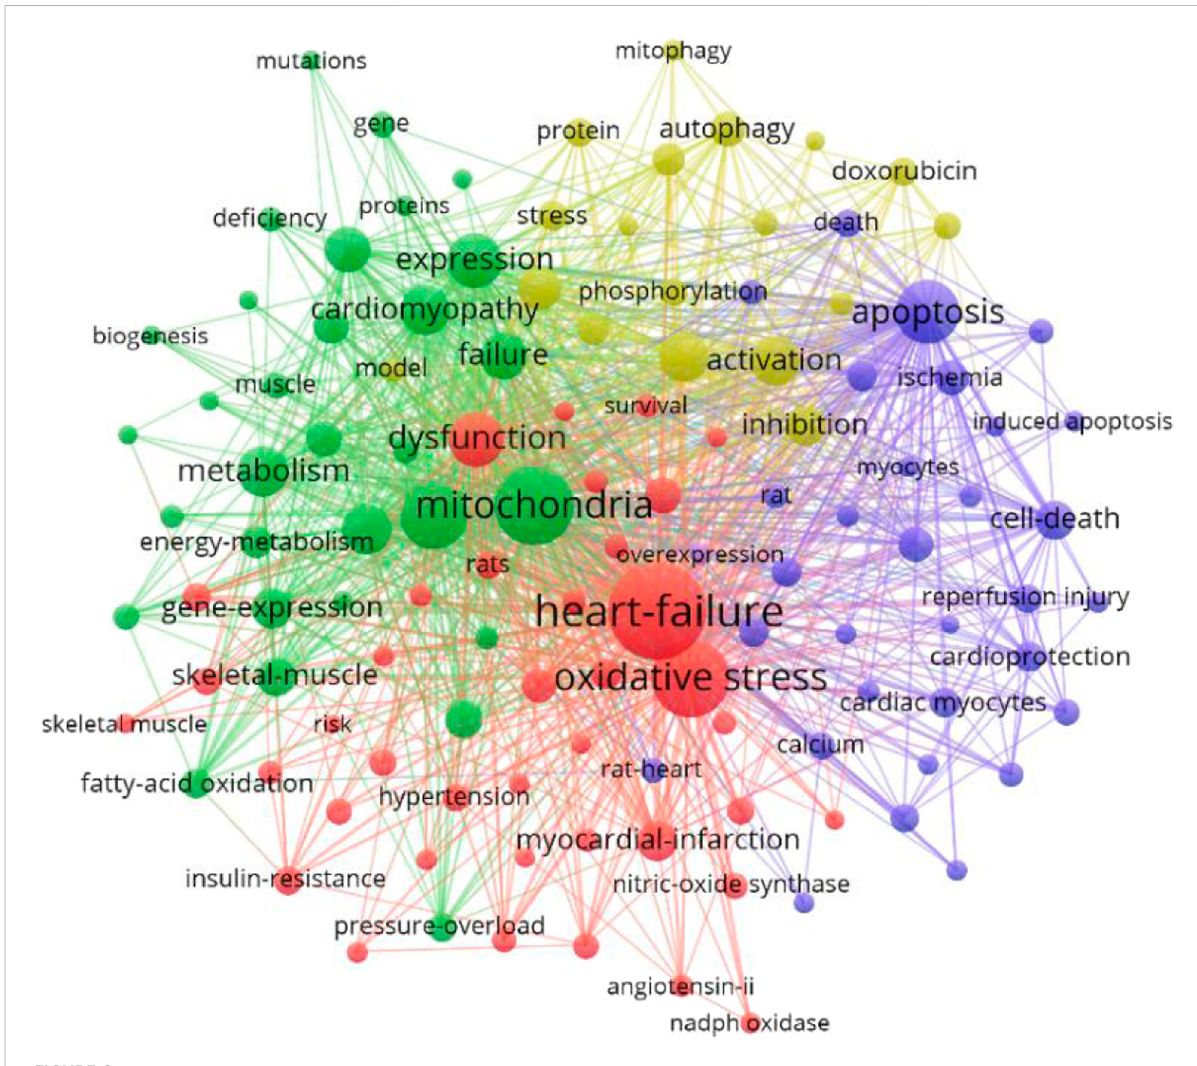
FIGURE 8 VOSviewer visualization map of keywords clustering